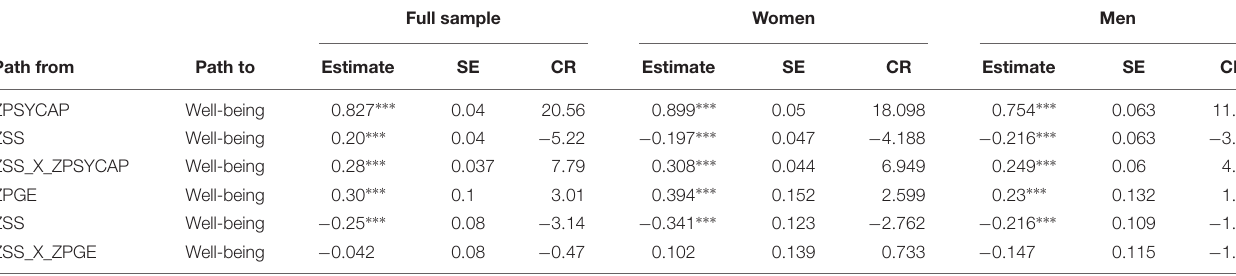
TABLE 7A | Moderation analysis: path estimates.